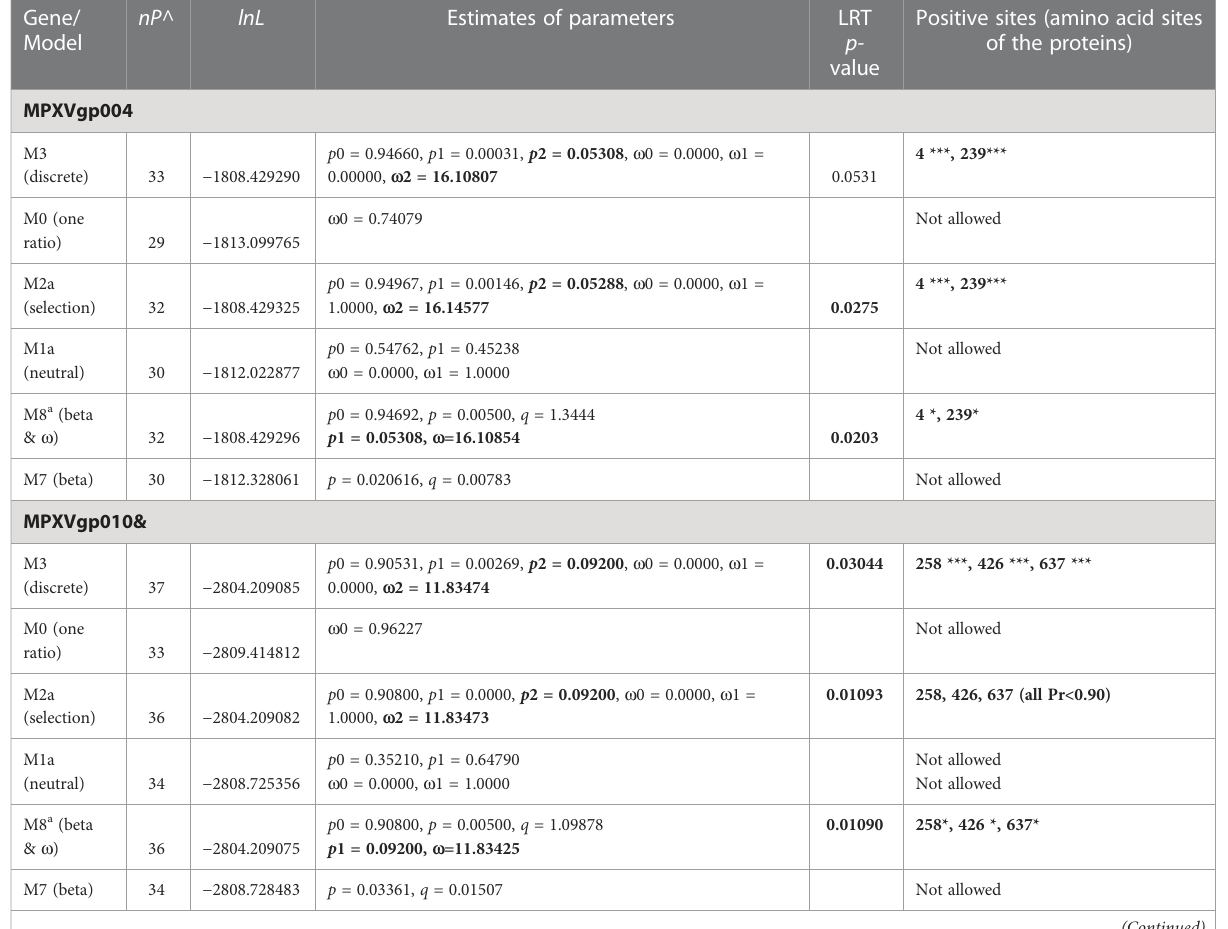
TABLE 2 Log-likelihood values and parameter estimates for the MPXV genes (positive selection ones are